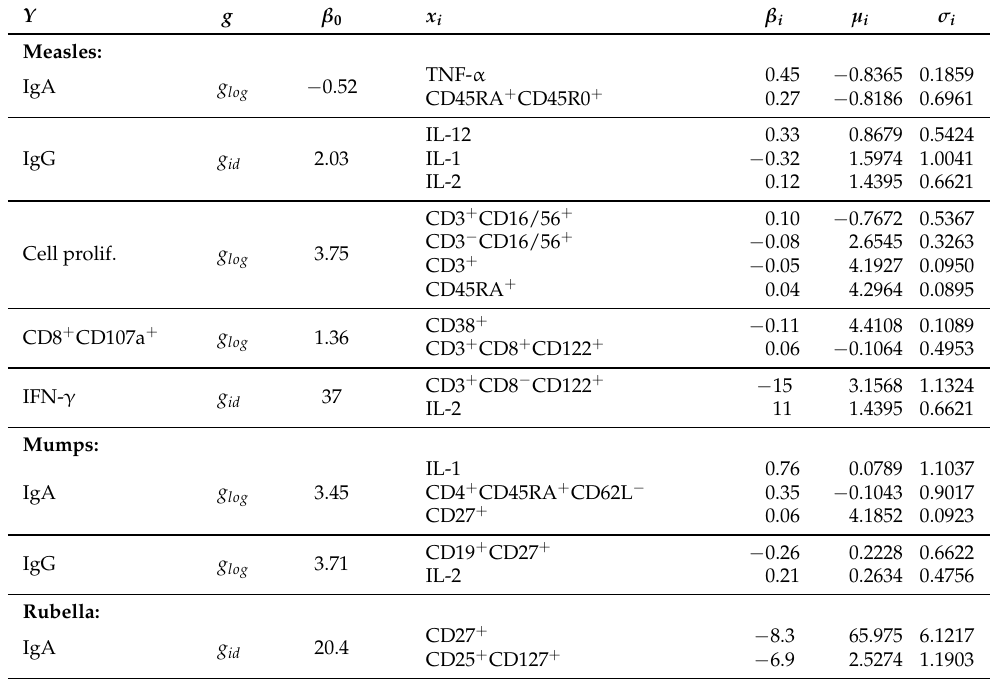
The estimated values of the regression coefficients β i , intercepts β 0 and scaling coeffi- cients µ i , σ i , as well as the form of function g are summarized in Table 2. Table 2. Summary of the parameters of the final multilinear regression models predicting post- vaccination immune response variables: regression coefficients β i , intercepts β 0 and scaling coeffi- cients µ i , σ i , the form of transformation function g